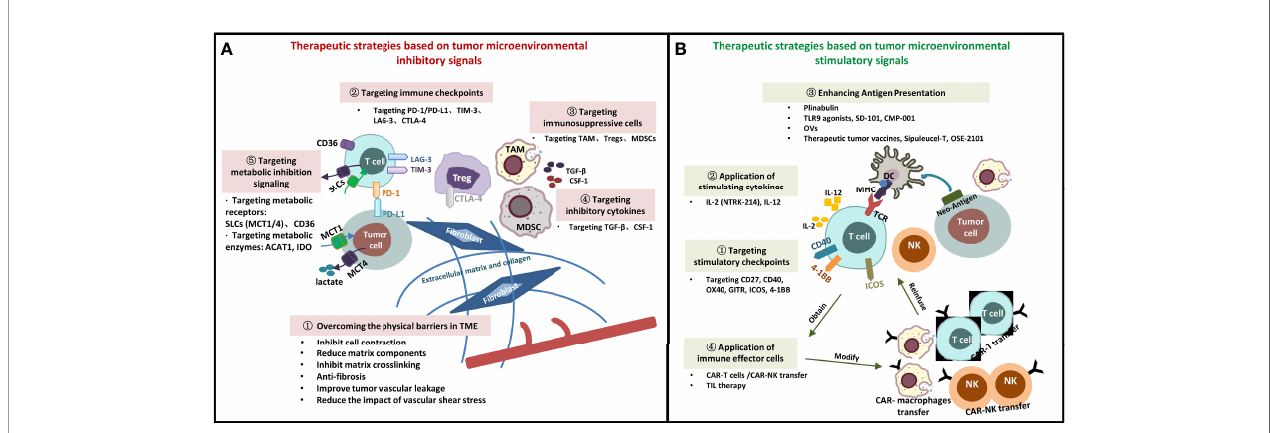
FIGURE 1 | Immunotherapeutic Strategies Targeting Tumor Microenvironment. (A) Therapeutic strategies based on tumor microenvironmental inhibitory signals; (B) Therapeutic strategies based on tumor microenvironmental stimulatory signals. SLCs, solute carrier transporters; DC, dendritic cell; MDSC, myeloid-derived suppressor cell; TAM, tumor-associated macrophage; Treg, regulatory cell; NK, natural killer cell; MHC, major histocompatibility complex; TCR, T cell receptor; PD-1, programmed cell death-1; PD-L1, programmed cell death-ligand 1; TIM-3, lymphocyte-activation gene -3; TGF- b , transforming growth factor- b ; CSF-1, colony- stimulating factor-1; CTLA-4, cytotoxic T lymphocyte-associated antigen-4; b 2M: b 2- microglobulin; MCT, monocarboxylate transporter; ACAT1, Acyl coenzyme A cholesterol acyltransferase 1; OVs, oncolytic viruses; TILs, in fi ltrating lymphocyte cells; CAR, chimeric antigen receptor; TLR, toll-like receptor